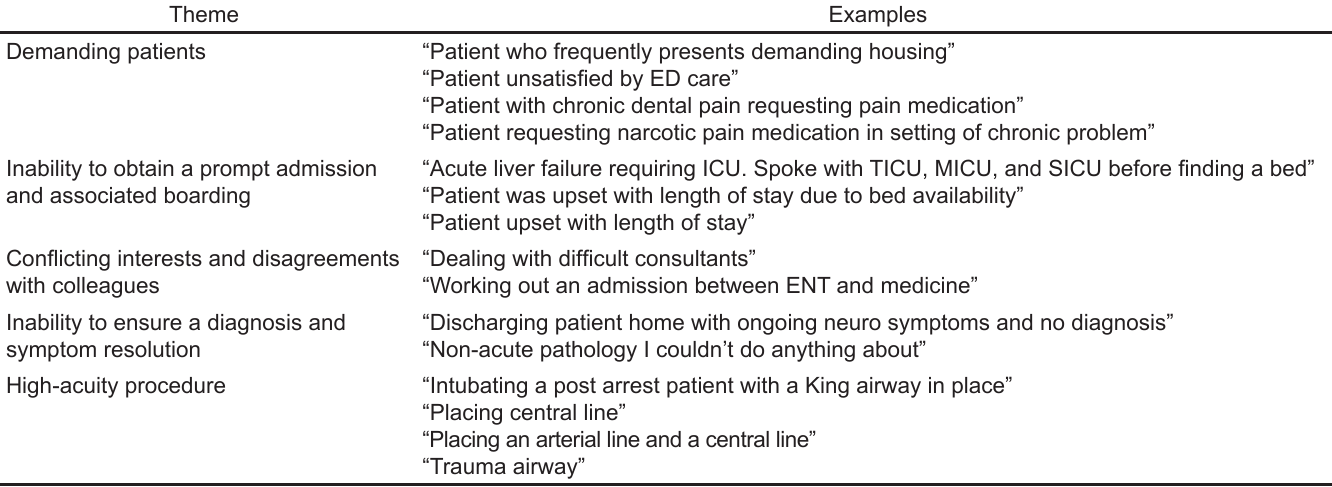
Table 3. Themes and examples from “describe the most stressful part of your shift.”